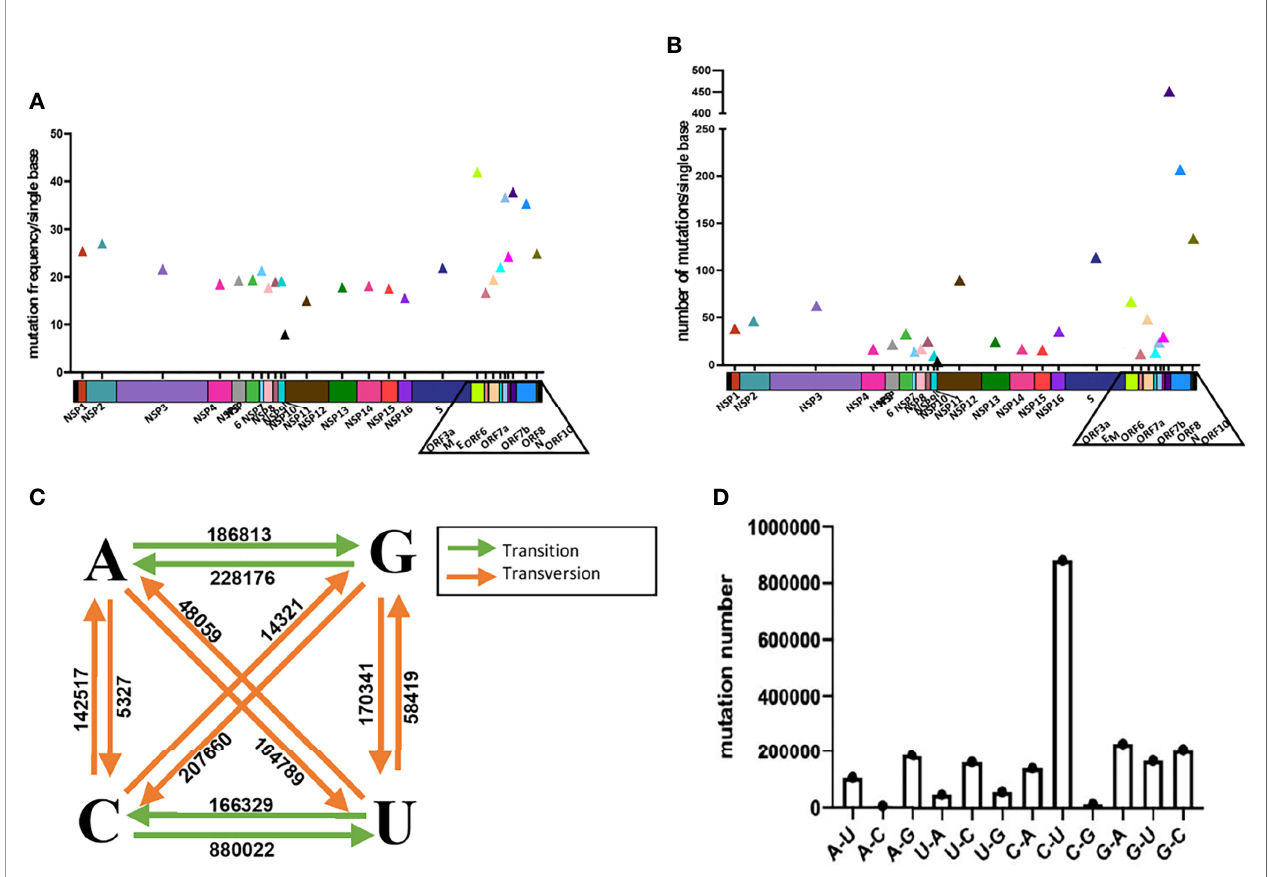
FIGURE 1 | Analysis of the mutations in SARS-CoV-2. Analyze the average mutation frequency (A) and number (B) of mutations per base of 89,791 SARS-CoV-2 sequences in 26 viral genes. Average mutation frequency = The total number of mutation sites of gene in 89,791 SARS-CoV-2 sequences/the total number bases of the gene. Average mutation number = The total number of mutations of gene in 89,791 SARS-CoV-2 sequences/the total number bases of the gene. (C, D) Analysis of base selection for mutations in 89,791 SARS-CoV-2